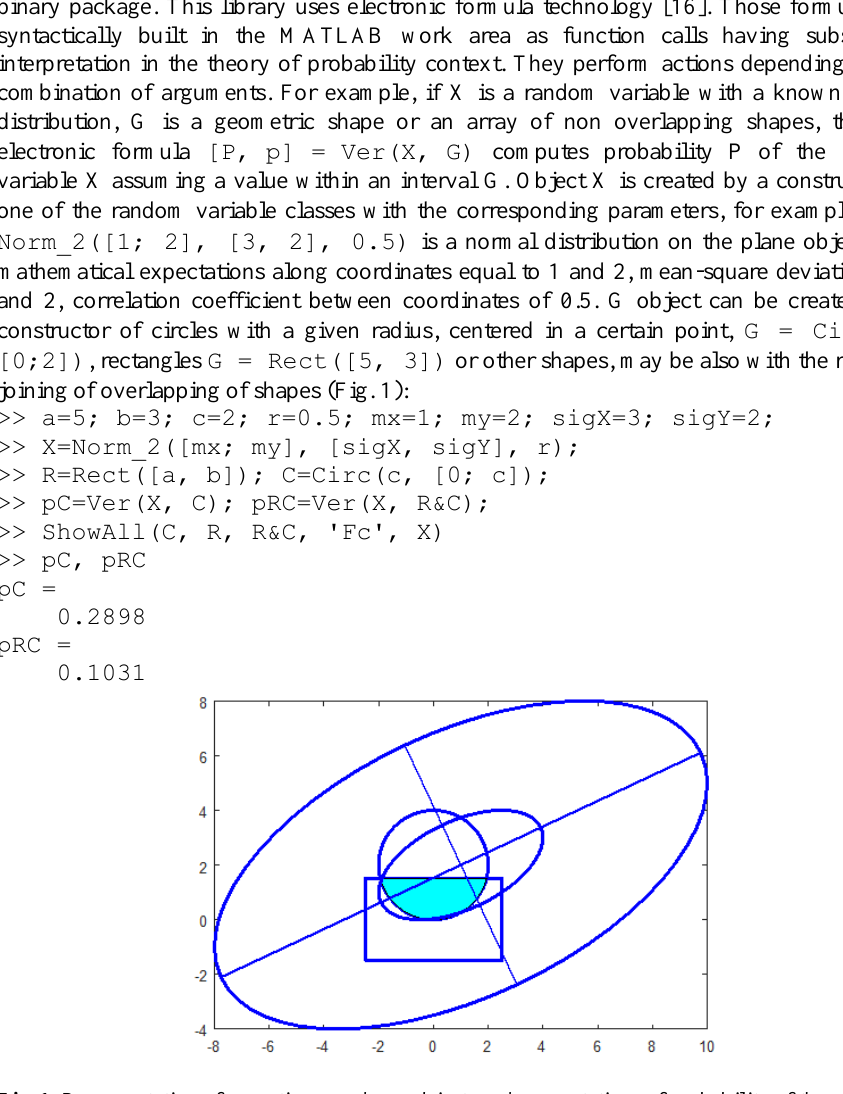
Fig. 1. Representation of operations on shape objects and computations of probability of the variable assuming a value within a given